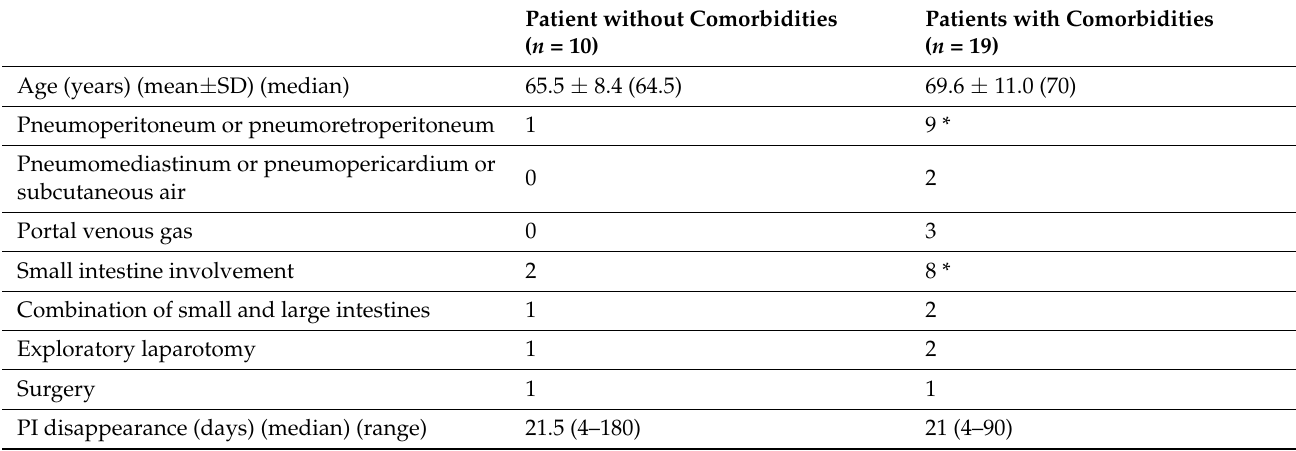
Table 3. Comparison between patients with and without